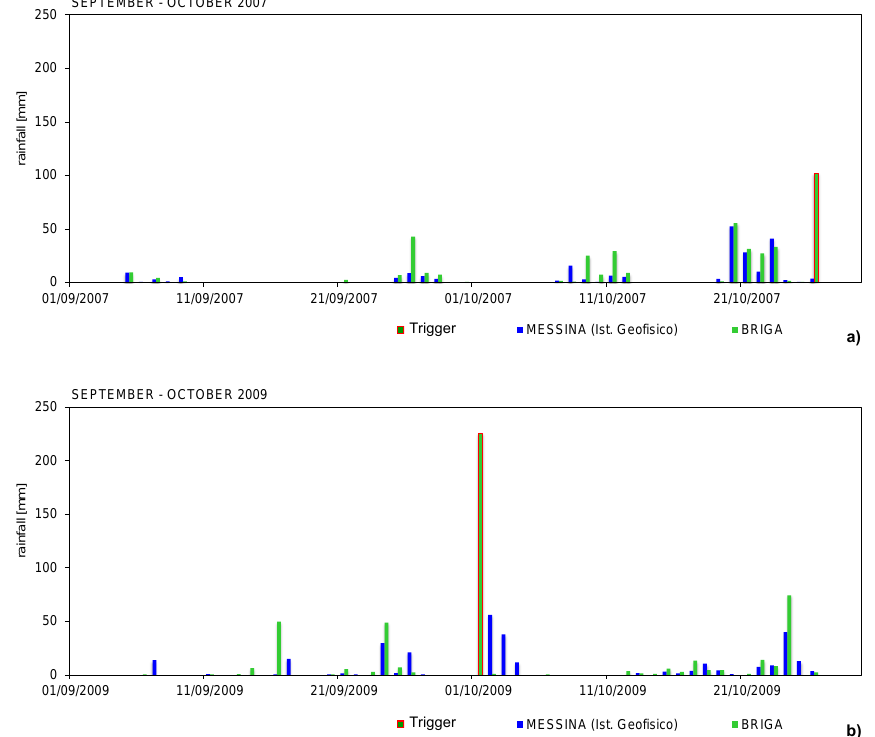
Figure 3. Time series of 2 months’ precipitation for the Messina (Ist. Geofisico) and Briga rain gauges: (a) October 2007; (b) October 2009.